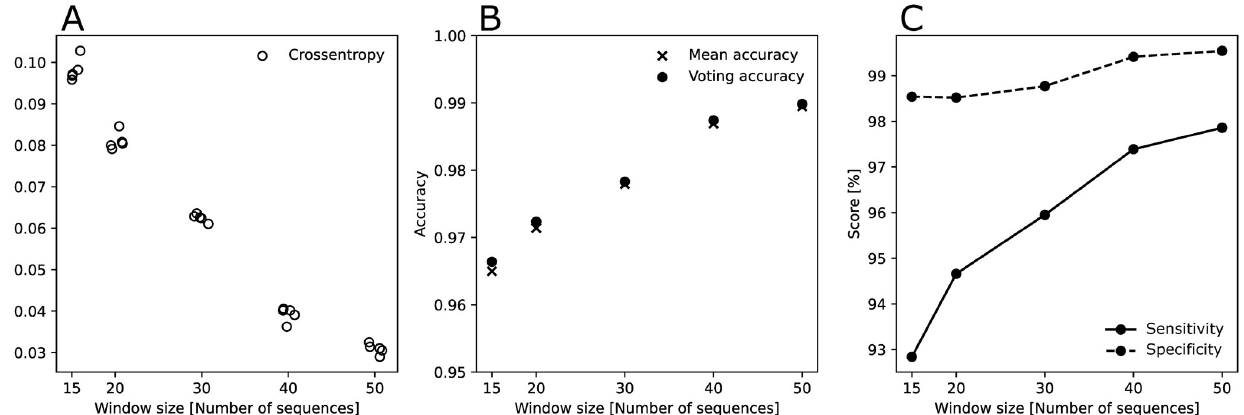
Fig 4. (A) Crossentropy of each trained neural network on the test sets. Crossentropy is a statistical measure of the average probability assigned to the incorrect labels by each model. Lower crossentropy indicates better model performance. Performance of networks trained on each subset of data are similar. (B) Accuracy of trained models. Constructing a voting classifier model from individual neural networks improves accuracy slightly. (C) Sensitivity (true positive rate) and specificity (true negative rate) of the voting models on the binary problem of identifying epidemic from endemic samples. Both sensitivity and specificity improve with a larger window